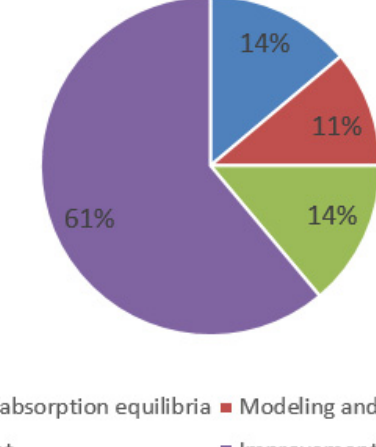
Figure 1. Percentage of articles mentioning the seawater flue gas desulfurization (SWFGD) process.